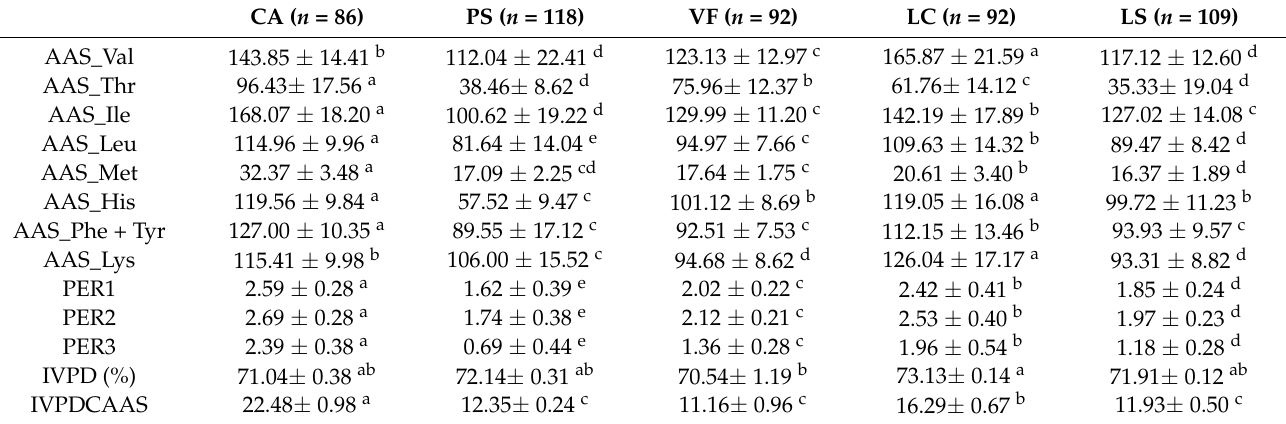
Table 1. Calculated protein quality, amino acid scores (AAS) considering the amino acid requirements of children between 2–5 years old in mg/16 g N [20] and protein efficiency ratio (PER), in vitro protein digestibility (IVPD), %, and in vitro protein digestibility corrected amino acid score (IVPDCAAS) determined for the different legume